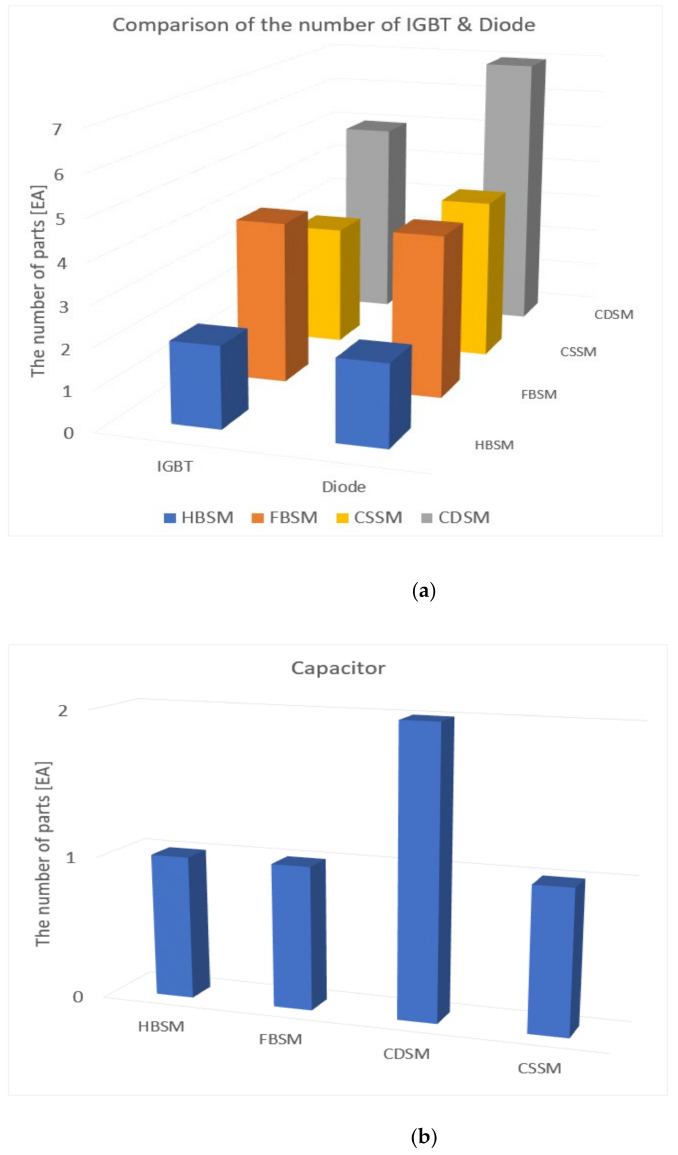
Figure 10. Comparison of the number of circuit components for ( a ) IGBT and diode, ( b )